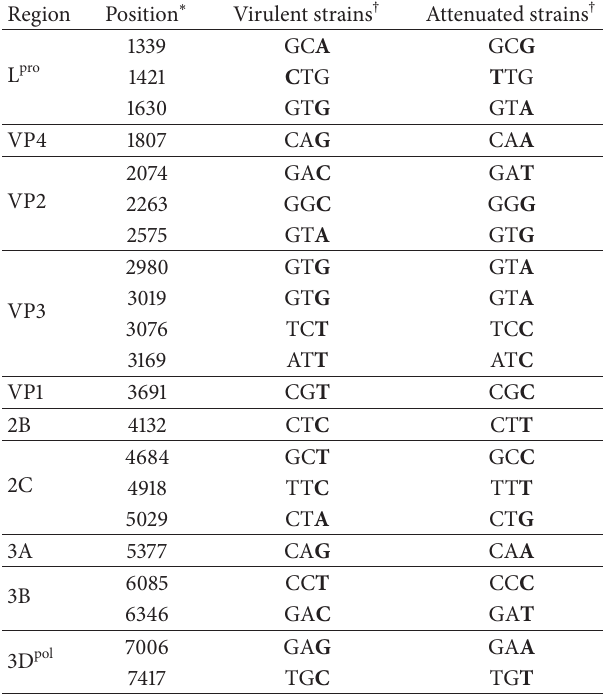
Table 4: Synonymous nucleotides substitutions in the protein coding region between the virulent and attenuated ZB strains.